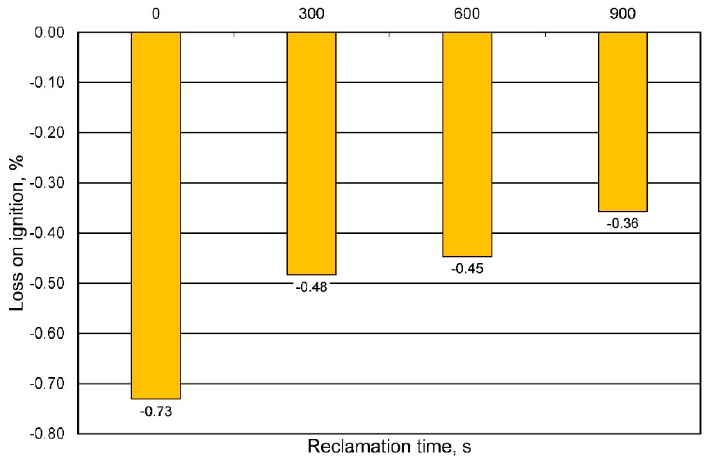
Figure 13. Ignition losses of used sand and reclaimed sand for different times of mechanical reclamation.